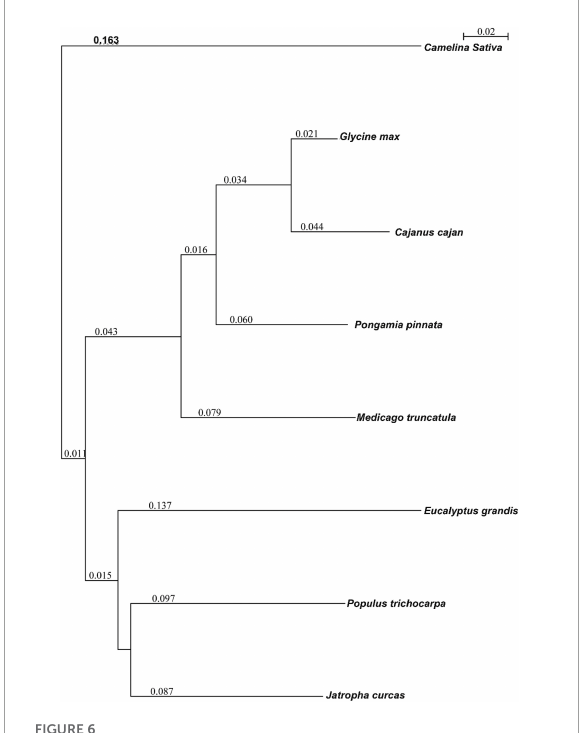
FIGURE6 The phylogenetic relationship of pongamia with other related organisms based on the orthologous proteins. A Seaview program was used to compute the phylogenetic tree. The program used a fast distance-based (Neighbor-Joining) method, BioNJ, to compute a full initial tree. The values present in the image represent the branch